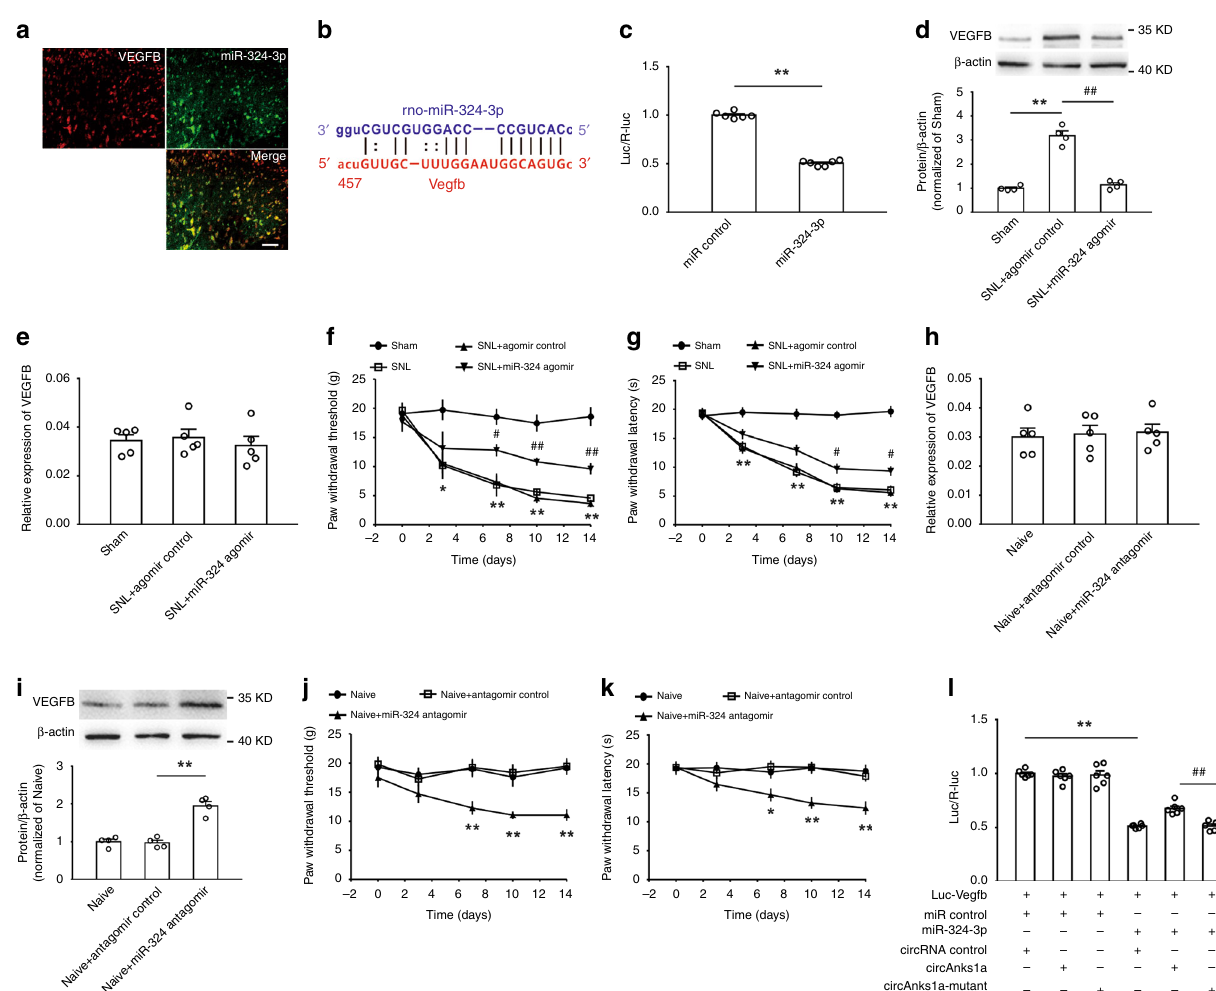
Fig. 10 CircAnks1a regulates VEGFB expression by targeting miR-324-3p following SNL. a MiR-324-3p colocalized with VEGFB-positive cells. Scale bar, 50 μ m ( n = 3). b A putative binding site between miR-324-3p and the 3 ’ UTR of VEGFB mRNA was predicted. c Administration of miR-324-3p mimics signi fi cantly suppressed luciferase activity ( ** P < 0.01 vs. miR control group, two-tailed two-sample t tests, n = 6). d The effect of miR-324-3p agomir (i.t.) on VEGFB protein levels on day 14 after SNL ( ** P < 0.01 vs. sham group, ## P < 0.01 vs. corresponding agomir group, two-tailed one-way ANOVA, n = 4). e Intrathecal injection of miR-324-3p agomir did not affect VEGFB mRNA expression on day 14 after SNL ( n = 5). f , g Intrathecal injection of miR-324-3p agomir attenuated mechanical allodynia and thermal hyperalgesia ( * P < 0.05, ** P < 0.01 vs. sham group, # P < 0.05, ## P < 0.01 vs. corresponding agomir group, two-tailed permutation tests, n = 12). h The effect of miR-324-3p antagomir on VEGFB mRNA ( n = 5). i Intrathecal injection of miR-324-3p antagomir increased VEGFB protein expression ( ** P < 0.01 vs. the corresponding antagomir group, two-tailed one-way ANOVA, n = 4). j , k The effect of miR-324-3p antagomir on mechanical allodynia and thermal hyperalgesia ( ** P < 0.01 vs. the corresponding antagomir group, two-tailed permutation tests, n = 12). l MiR-324-3p mimics signi fi cantly decreased the luciferase activity, and the circAnks1a overexpression vector rescued the reduced luciferase